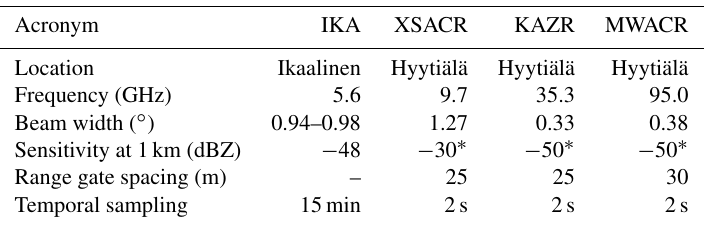
Table 1. Radar technical specifications are shown for C-band polarimetric Doppler weather radar and for the ARM cloud radar systems at X, Ka and W